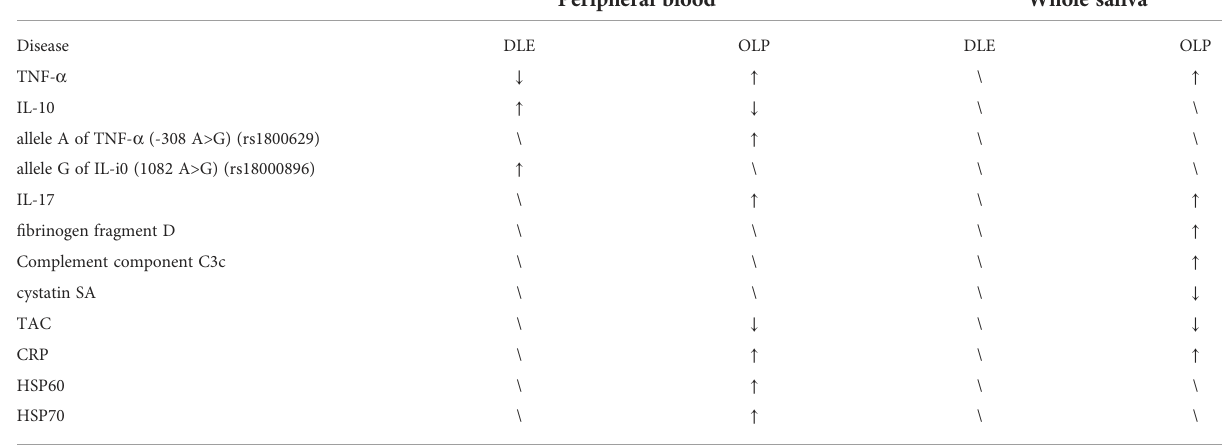
TABLE 2 Samples and assay indexes for differential diagnosis.